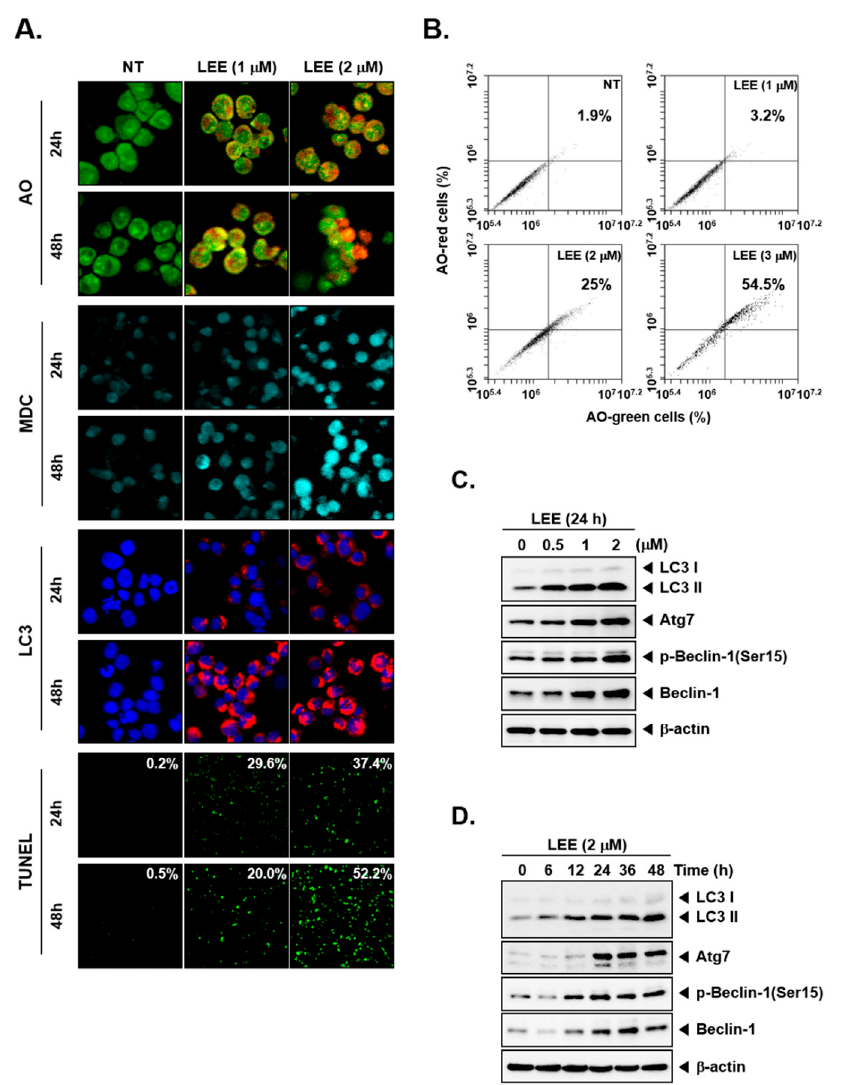
Figure 2. Induction of autophagy by LEE. ( A ) KBM5 cells (5 × 10 5 cells/well) were treated with LEE (0, 1, and 2 μ m) for 24 or 48 h. Autophagy was detected by AO, MDC staining or probed with LC3 antibody for immunocytochemistry. ( B ) Autophagy was measured by AO staining. KBM5 cells were treated with LEE (0, 1, 2, and 3 μ m) for 48 h and analyzed by cell flow cytometry. ( C ) KBM5 cells were treated with LEE (0, 0.5, 1, and 2 μ m) for 24 h and autophagy markers were measured by Western blot analysis. ( D ) KBM5 cells were treated with LEE (2 μ m) for indicated time intervals (0, 6, 12, 24, 36, and 48 h) and proteins were evaluated by Western blot analysis.